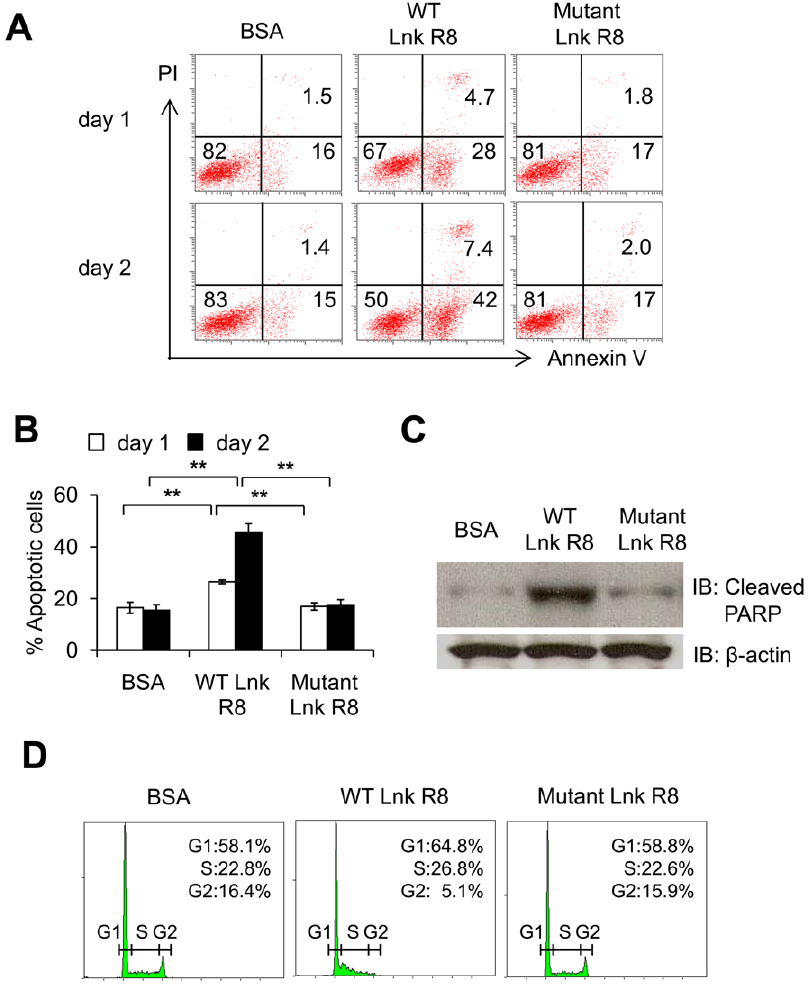
Figure 5. WT Lnk R8 induces cell cycle arrest and promotes apoptosis. (A) M-MOK cells were pre-treated with 5 m M of WT, mutant Lnk R8 or BSA for 6 hours before TPO addition. Cells were harvested at 24 or 48 hours after TPO stimulation. Cells were stained with FITC-Annexin V and PI to analyze apoptotic (Annexin V + PI-) and dead (Annexin V + PI + ) cell fractions through flow cytometry. (B) Bar graph showing percentages of apoptotic cells for each treated sample at 24 or 48 hours after TPO addition. (Data represent mean 6 SD and results are representative of three independent experiments, **p , 0.01 ). (C) 48 hours after TPO addition, lysates from protein-treated M-MOK samples were subjected to Western blotting with cleaved PARP or b -actin antibodies. (D) 24 hours after TPO addition, protein-treated M-MOK samples were stained with PI and subjected to flow cytometry analysis. (Data represent one experiment of two independent experiments).